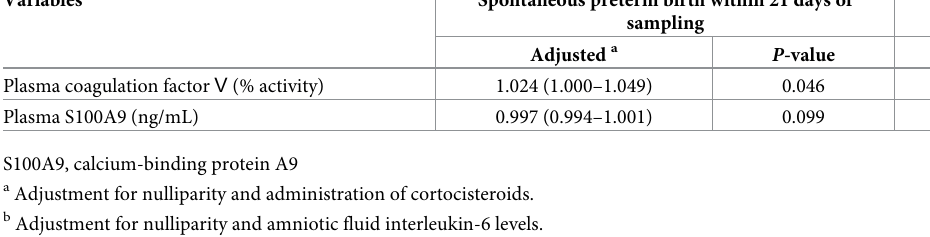
Table 2. Relationship between plasma coagulation factor Ⅴ and S100A9 and spontaneous preterm birth � 21 days of sampling or at < 34 weeks in women with pre- term labor without infection and/or inflammation, analyzed by multiple logistic regression analysis.